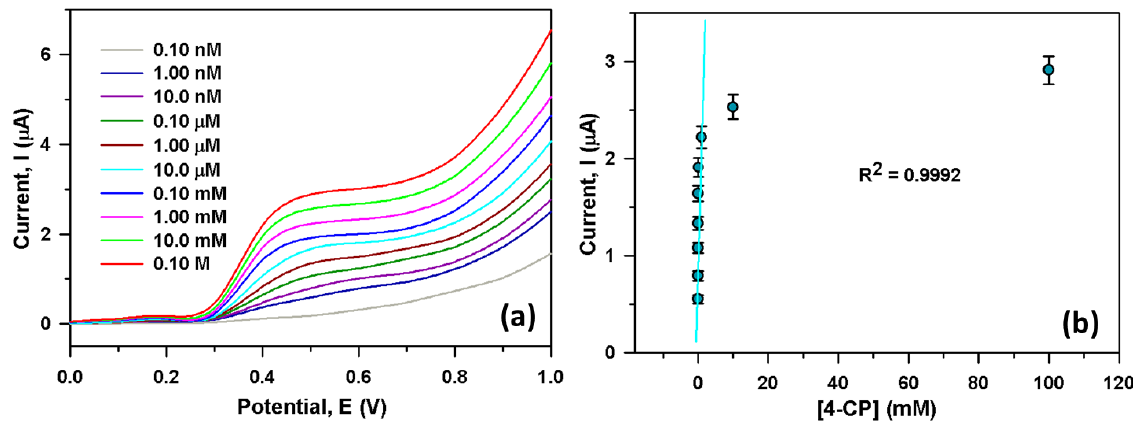
Figure 4. ( a ) Electrochemical responses for different 4-CP solution (0.10 nM to 0.10 M) and ( b ) Calibration curve of the CGO/Au / μ -Chip at +0.5 V.